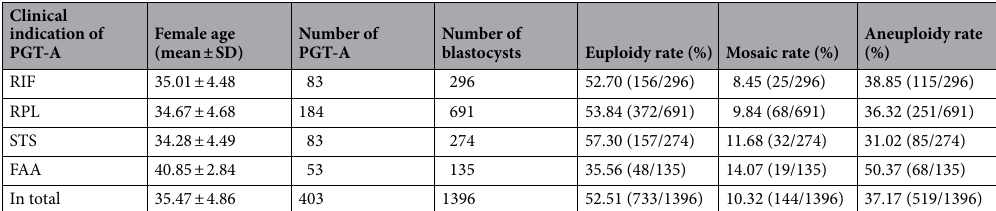
Table 1. Introduction of PGT-A treatments in this